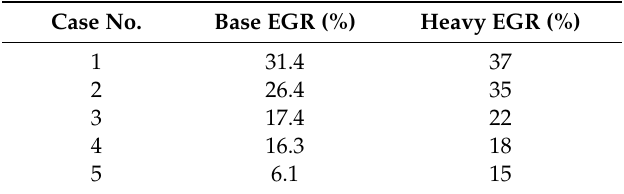
Figure 8. Comparison of EGR rate, maximum in-cylinder pressure (Pmax), air fuel (A / F) ratio, BSFC, and BSNO x between the base engine and heavy EGR-applied engine in each case. Table 5. Heavy EGR